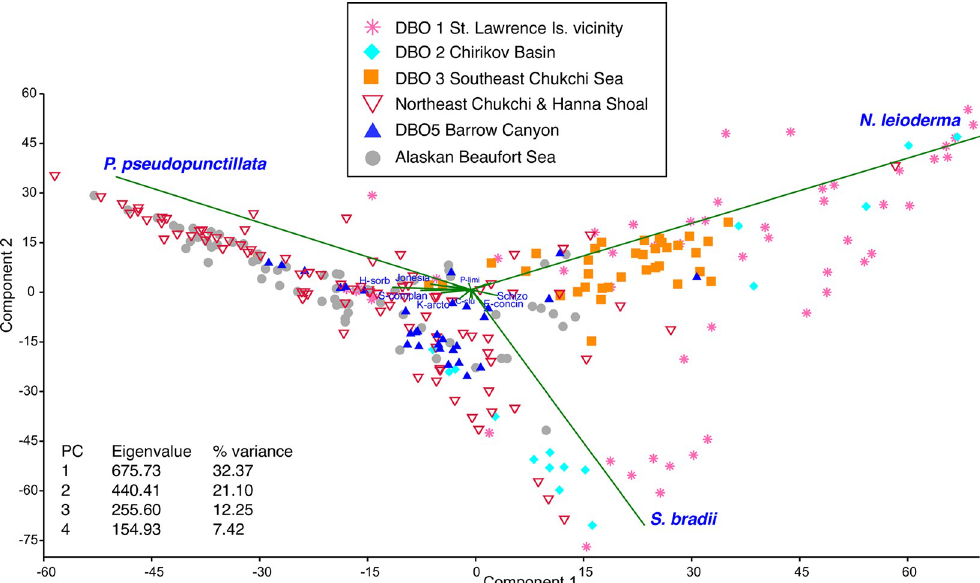
Fig 5. Principal Correspondence Analysis (PCA). PCA of ostracode assemblages in the northern Bering, Chukchi and Beaufort Sea region (locations on Fig 1; geographic coordinates in Table 1), with sites designated by DBO areas and other ecoregions (legend symbols) and major taxa (green lines with species names labeled in blue). Three species dominate the assemblage groups: N . leioderma , S . bradii , and P . pseudopunctillata . The proximity of the symbols in the plot reflects the level of similarity in taxa present at each sampling